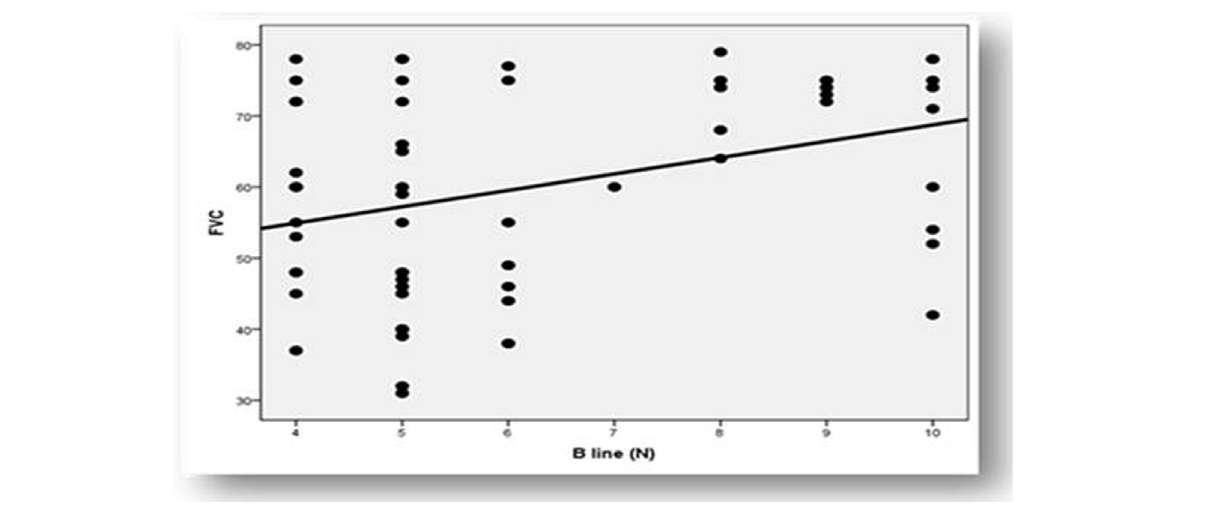
The relation between B-line number and forced vital capacity (FVC).